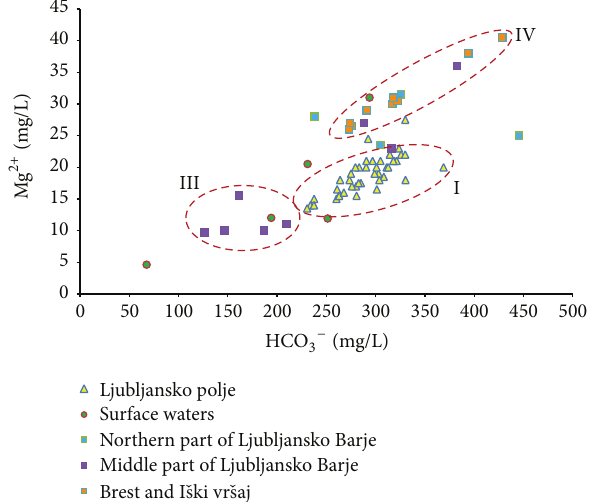
Figure3:RelationshipbetweenHCO 3− andMg 2+ ingroundwaterof Ljubljansko polje and Ljubljansko Barje aquifers. Roman numerals represent groups of groundwater from (I) Ljubljansko polje aquifer, (III)middle part of Ljubljansko Barje aquifer, and (IV) Brest and Iˇski vrˇsaj aquifer.